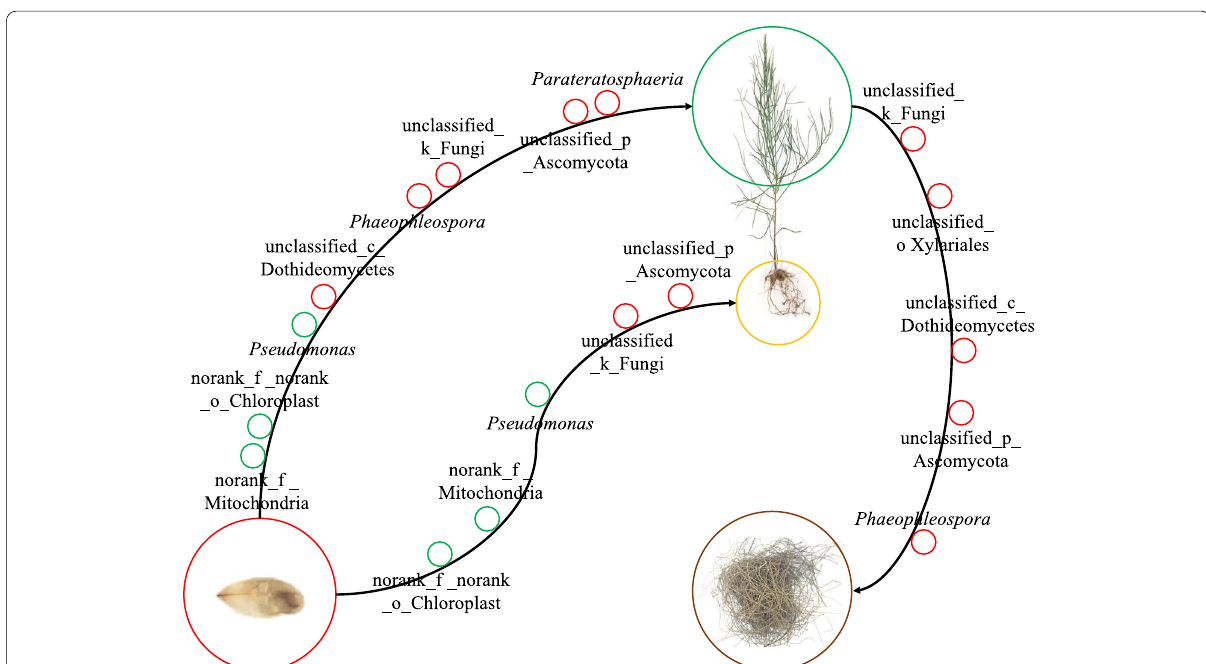
Fig. 5 Vertical transmission of the core microbiome from seeds to branchlets, roots, and litter of C. equisetifolia at the genus level. Microbial genera: red circles represent fungi and green circles represent bacteria. Compartment niches: red cycle represents seed and green cycle represents branchlet, with yellow cycle representing root as well as brown cycle representing